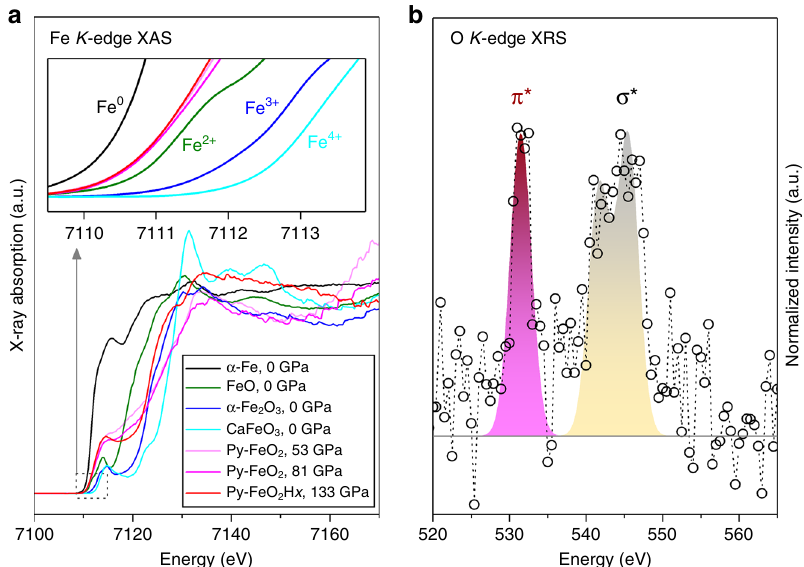
Fig. 1 Representative XAS and XRS spectra of iron oxide compounds. a PFY-XAS spectra at Fe K -edge of iron oxide compounds at room temperature. Black, olive, blue, and cyan lines: Fe 0 , Fe 2 + O, Fe 3 + 2 O 3 , and CaFe 4 + O 3 at ambient conditions, respectively; light and dark magenta lines: Py-FeO 2 at 53 and 81 GPa, respectively; red line: Py-FeO 2 H x at 133 GPa; gray arrow: the link from the dashed outline to the inset. Inset: the area zoomed for the dashed outline in Fig. 1a. b XRS spectra of Py-FeO 2 H x at 110 GPa. Circles: experimental data; shaded areas: fi tted